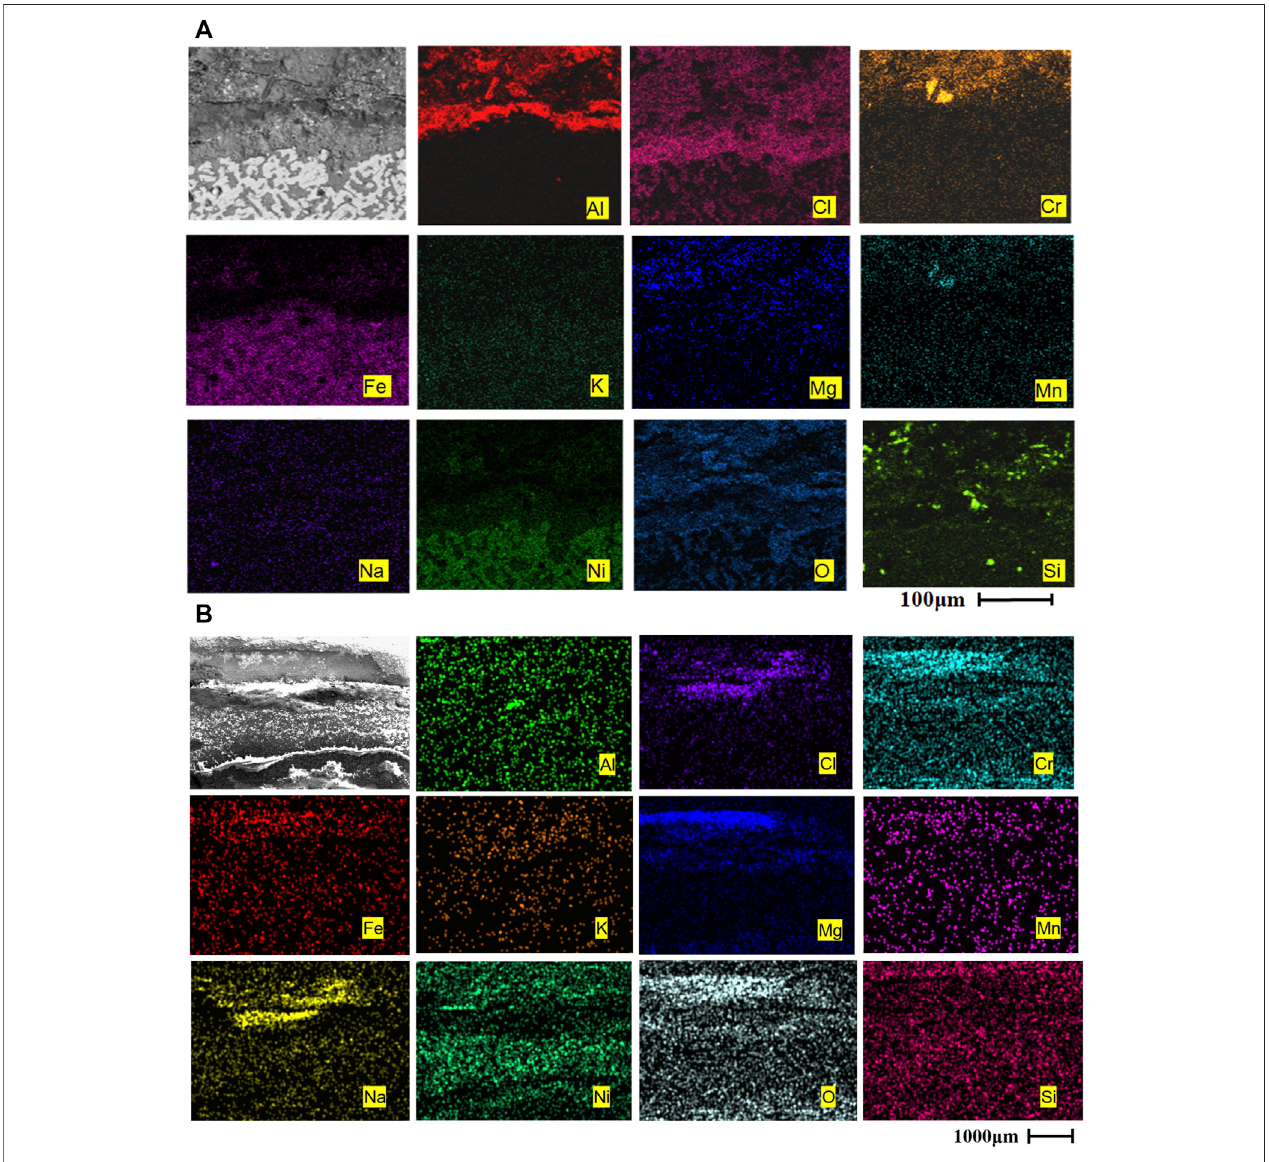
FIGURE 9 | Cross-sectional morphologies and EDS mapping of two alloys after corrosion at 800 ° C for 360 h: (A) AFA 310S, (B) commercial 310S